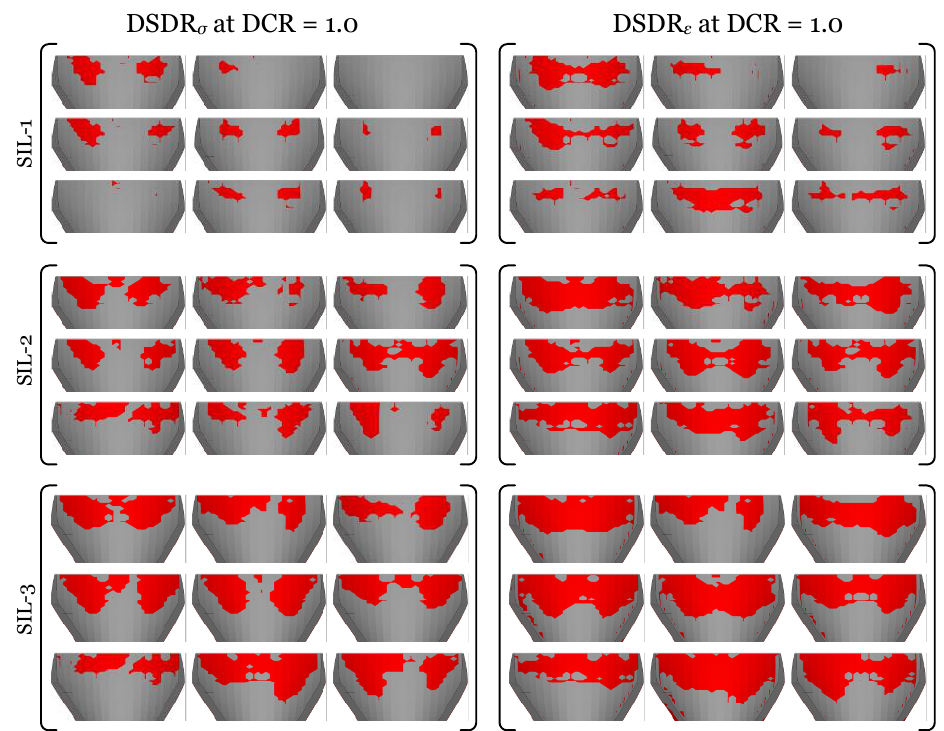
Figure A2. Matrix of over-stress and over-strain area on Dam-2 downstream face; Note: Each matrix includes 9 plots associated with 9 ground motions. In each matrix, top-left to bottom-right are #1 to